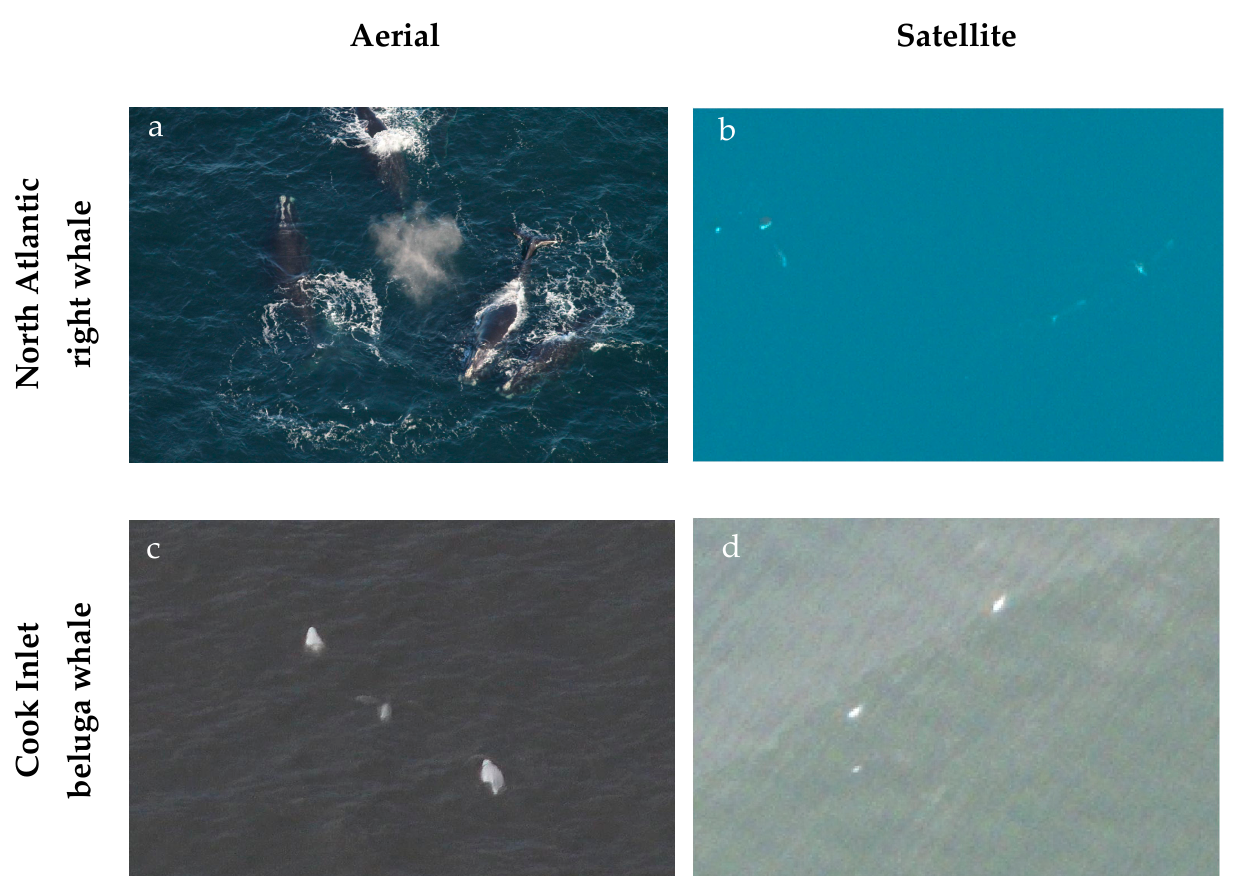
Figure 1. A comparison of imagery collected during aerial surveys and from VHR satellites for the North Atlantic right whale and the Cook Inlet beluga whale. ( a ) An aerial photograph of a North Atlantic right whale taken from a handheld 300 mm fixed lens from a NOAA Twin Otter aircraft. Image collected under MMPA Research Permit 17355; ( b ) A WorldView-3 satellite image of a North Atlantic right whale (Catalog ID: 10400100674B2100, Standard 2A product, pansharpened at 0.5 m/px resolution); ( c ) An aerial still image of Cook Inlet beluga whales captured from video footage collected on a Sony FDR-AX700 video handycam (3840 × 2160 pixel resolution) at 800 ft altitude. Video collected under MMPA Research Permit 25563; ( d ) A WorldView-3 satellite image of Cook Inlet beluga whale (Catalog ID: 104001006F3F8E00, Basic 1B product, pansharpened at a 0.37 m/px resolution). Satellite images © 2023 Maxar